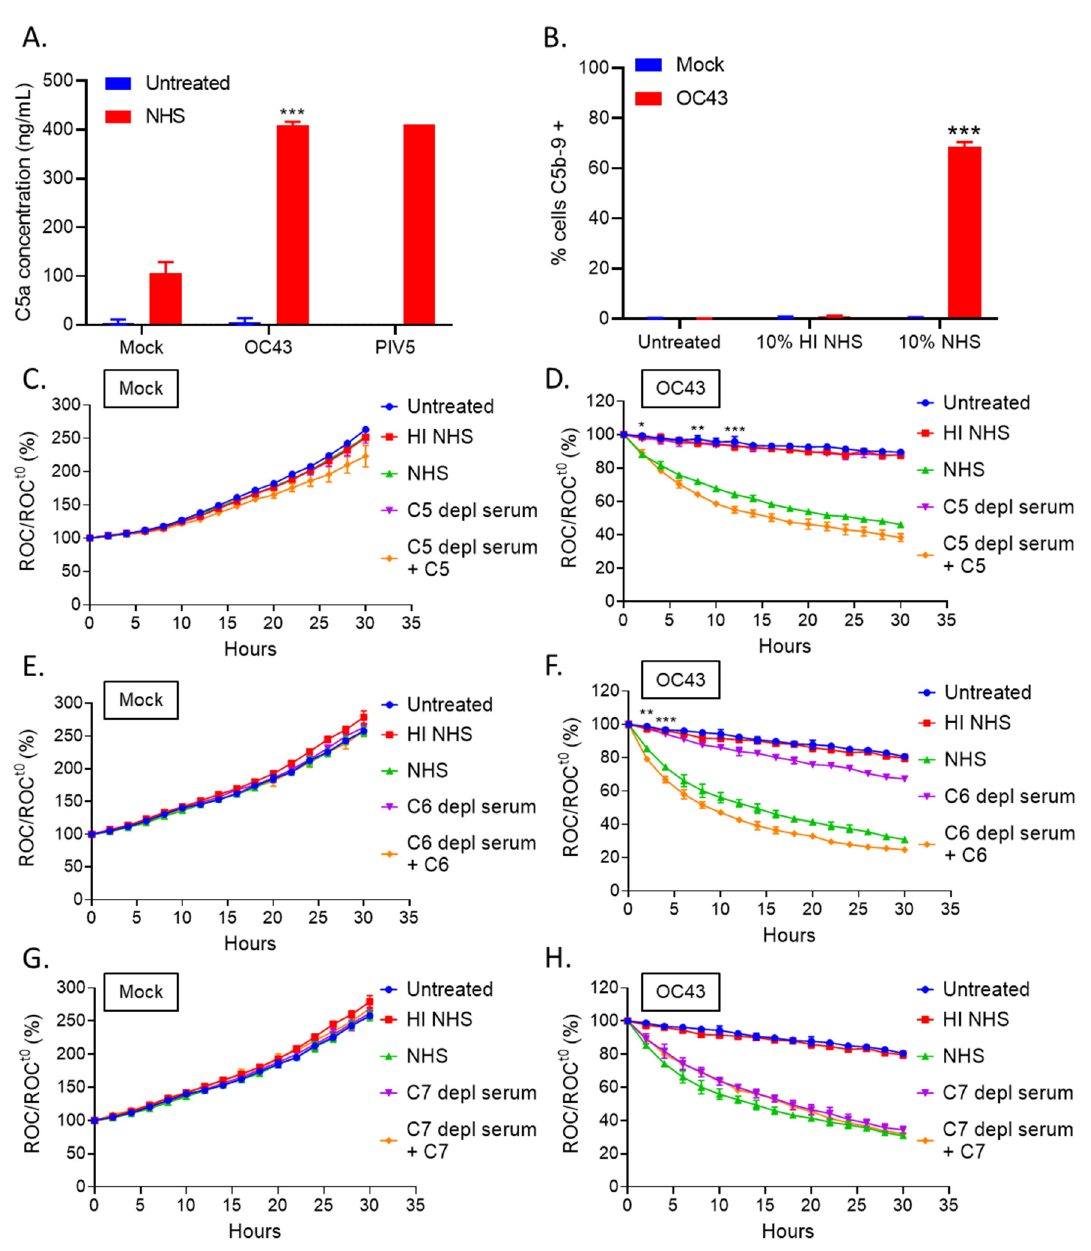
Figure 4. C5 and C6 are required for C’-mediated lysis of OC43 infected lung cells. ( A ) Uninfected (mock), OC43, or PIV5 infected H1299 cells were either left untreated, or treated with NHS for 4 h at 37 °C. Supernatants were collected and analyzed for C5a concentrations via ELISA. ( B ) Uninfected (mock) or OC43 infected H1299 cells were either left untreated, or treated with HI NHS, or NHS treated for 1 h. After incubation, cells were washed and stained for surface C5b-9 and quantified by flow cytometry. ( C – H ) H1299-NLR cells were uninfected (mock) ( C , E , G ) or infected with OC43 ( D , F , H ) at an MOI of 5 TCID 50 units per cell and then were either left untreated or treated with 10% HI NHS, 10% NHS, 10% C5-depl serum, or 10% C5-depl serum supplemented with physiological levels of C5 ( C , D ). Brightfield phase and red fluorescent images were acquired by real-time imaging using the IncuCyte instrument at 2 h intervals over 30 h. ROC per well was calculated and normalized to the value at time zero (ROC t0 ) when treatments were added and expressed as percent of time zero. For panels ( E , F ), 10% C6-depl serum or 10% C6-depl serum supplemented with physiological levels of C6 were tested as indicated. For panels ( G , H ), C7-depl serum or 10% C7-depl serum supplemented with physiological levels of C7 were tested as indicated. Values in all panels are the mean of three replicates and error bars representing standard deviation, with * indicating p -value of <0.05, ** indicating p -value of <0.01 and *** indicating p -value of <0.001 comparing NHS treated OC43